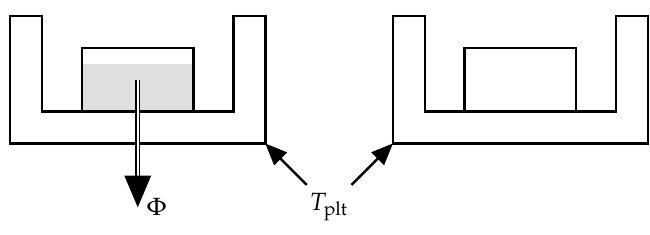
Figure 5. Schematic representation of a DSC system.